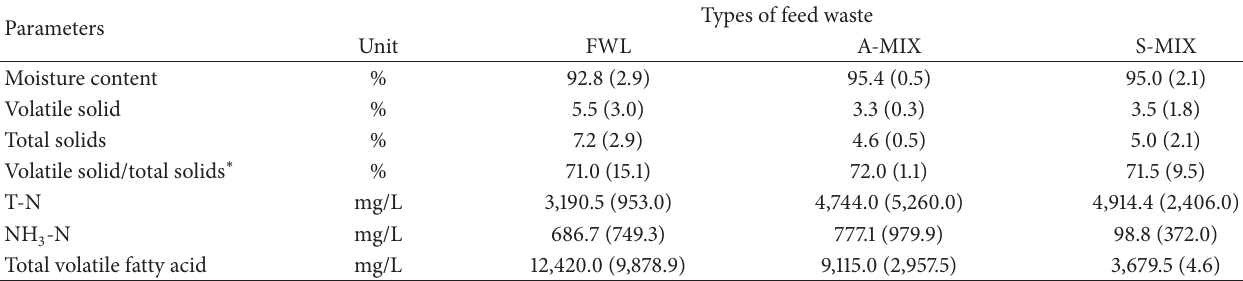
Table 2: Physicochemical characteristics of feed